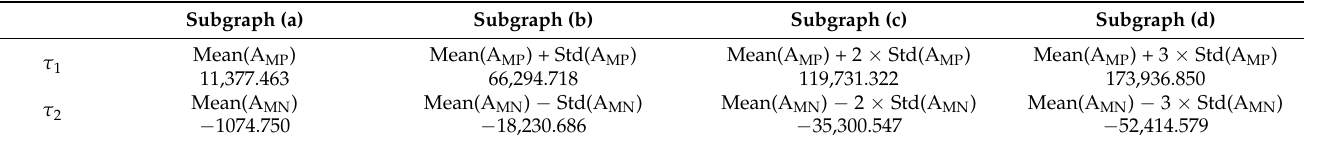
Figure 8. The distribution of node degrees with different thresholds. The subgraph ( a ) is the distribution of node degree with thresholds Mean(A MP ) and Mean(A MN ); subgraph ( b ) is the distribution of node degree with thresholds Mean(A MP ) + Std(A MP ) and Mean(A MN ) − Std(A MN ); subgraph ( c ) is the distribution of node degree with thresholds Mean(A MP ) + 2 × Std(A MP ) and Mean(A MN ) − 2 × Std(A MN ); subgraph ( d ) is the distribution of node degree with thresholds Mean(A MP ) + 3 × Std(A MP ) and Mean(A MN ) – 3 × Std(A MN ). Table 1. Different values of τ 1 and τ 2 Table 2. The number of edges with different values of 𝜏 1 and 𝜏 2 .